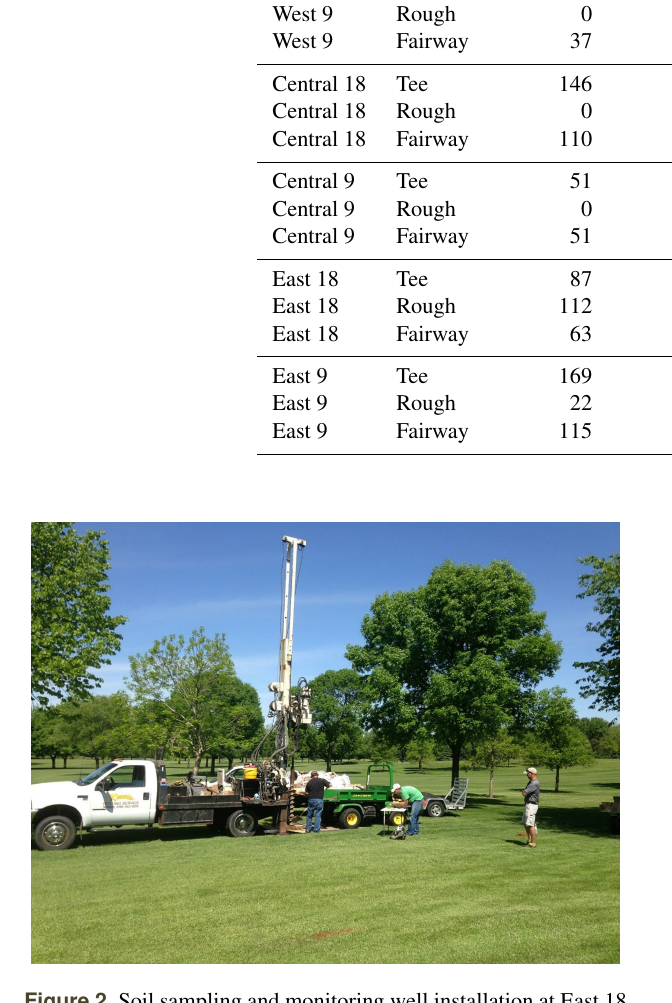
Figure 2. Soil sampling and monitoring well installation at East 18